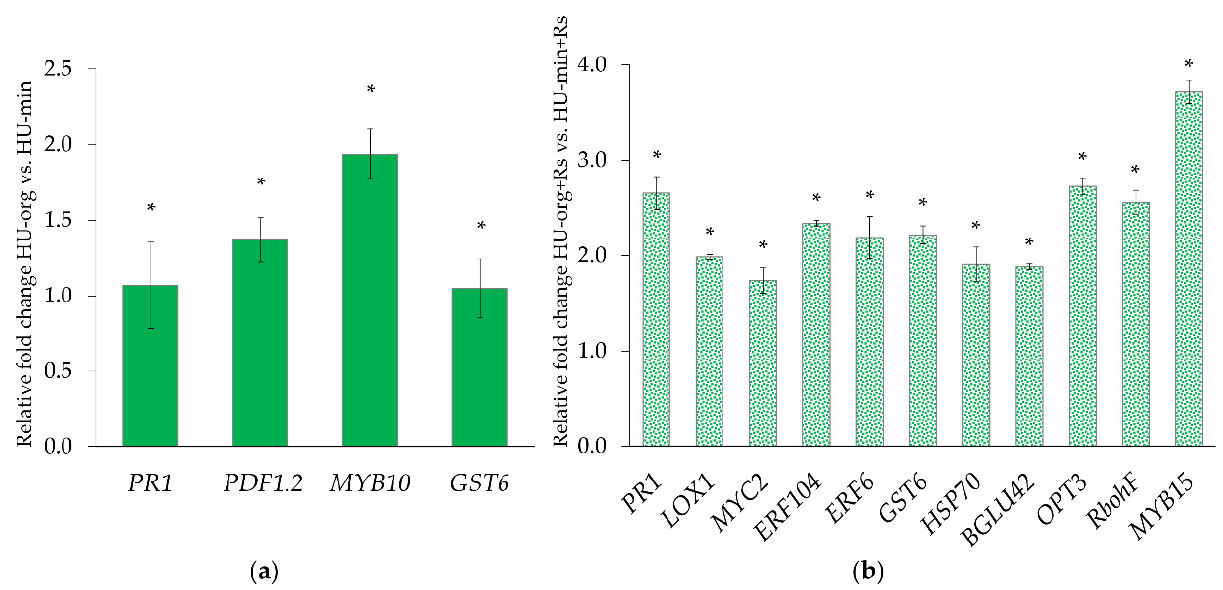
Figure 2. Relative fold changes of gene expression associated with biotic/abiotic stress signaling in lettuce (cv. Tizian): ( a ) plants grown in soils with long-term organic (HU-org) compared to mineral (HU-min) fertilization, ( b ) plants grown in presence of Rhizoctonia solani AG1-IB (+Rs) in organic- (HU-org + Rs) compared to plants grown in mineral-fertilized soil (HU-min + Rs). * Indicates significant differences according to Tukey’s HSD test ( p < 0.05).